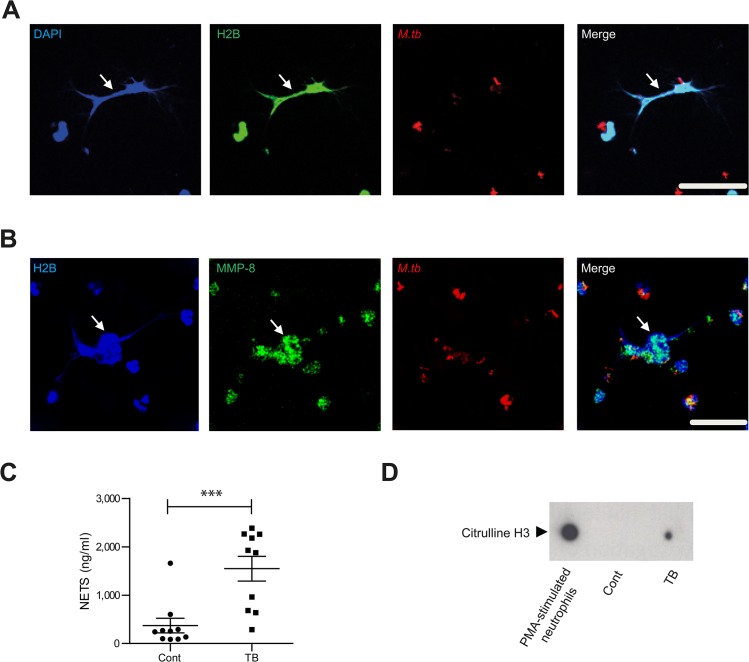
Neurophil MMP-8 associates with NETs.(A and B) Neutrophils were infected with M.tb MOI of 10 for 4 hours and NETs stained with DAPI (blue), anti-histone 2B (H2B, green) or anti-MMP-8 (green), while M.tb was stained with anti-M.tb Ab (red). Mtb induces NET formation which do not adhere to the shape of the neutrophil nuclei (White arrows). Scale bars represent 25 μm. (C) Induced sputum NETs were greater in patients with TB than healthy controls (n = 10 both groups analyzed by Student’s t-test). (D) NETs marker citrulline H3 is present in induced sputum of TB patients but not in healthy controls. Blot representative of n = 2 both groups.